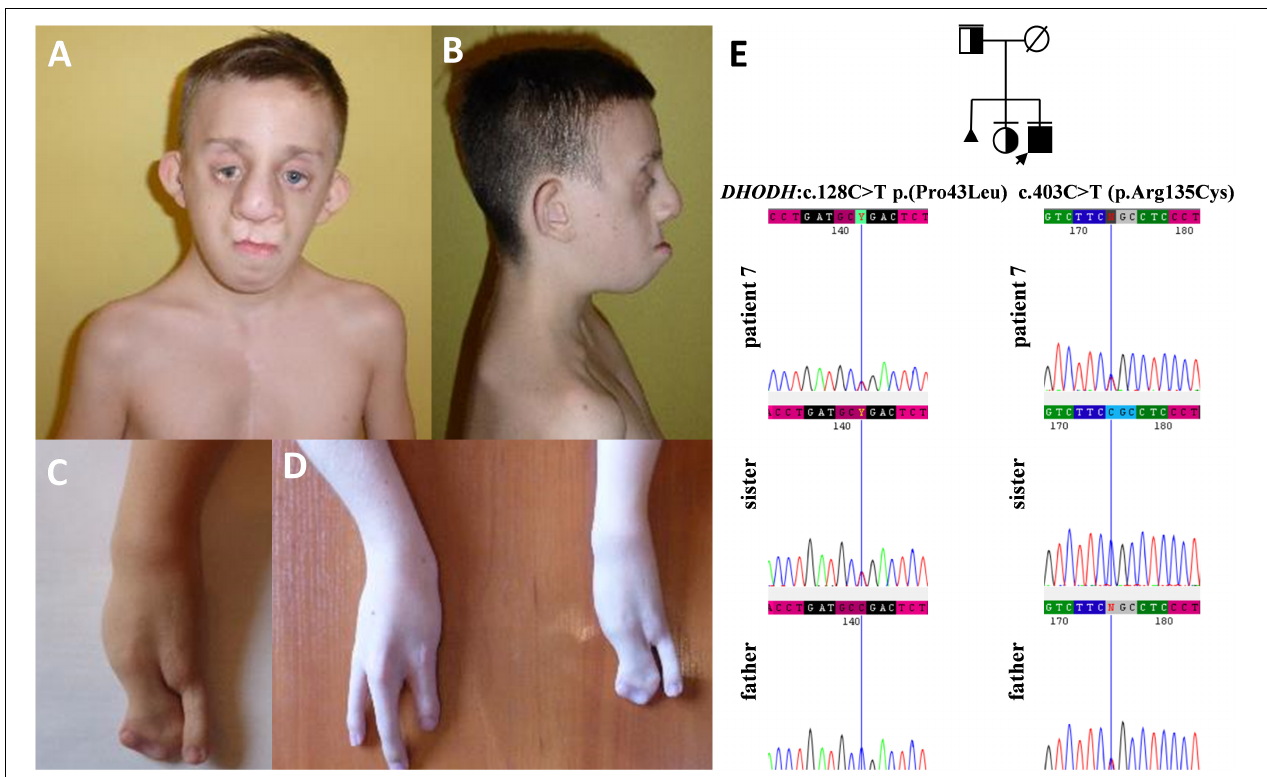
FIGURE 6 | Clinical characteristics (A–D) and segregation results (E) of patient 7 affected by Miller syndrome. Patient 7 carries c.403C > T (p.Arg135Cys) and c.128C > T p.(Pro43Leu) missense variants, both located in trans orientation in the DHODH gene (E)